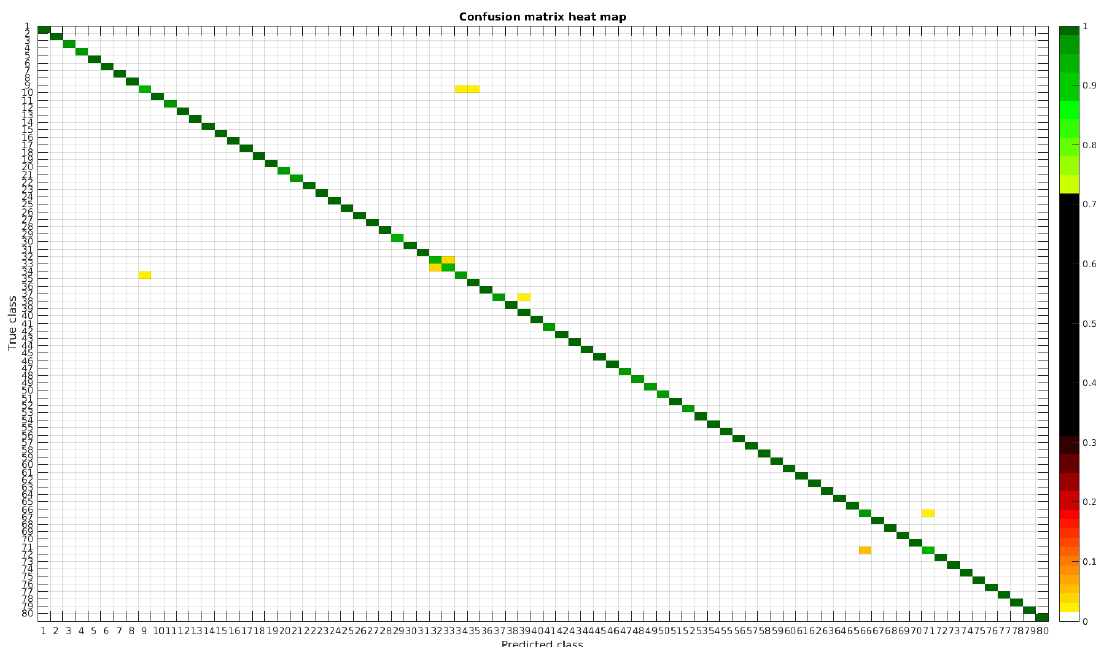
Figure 15. Confusion matrix heat map for the normalized dataset with 1000 samples per class.